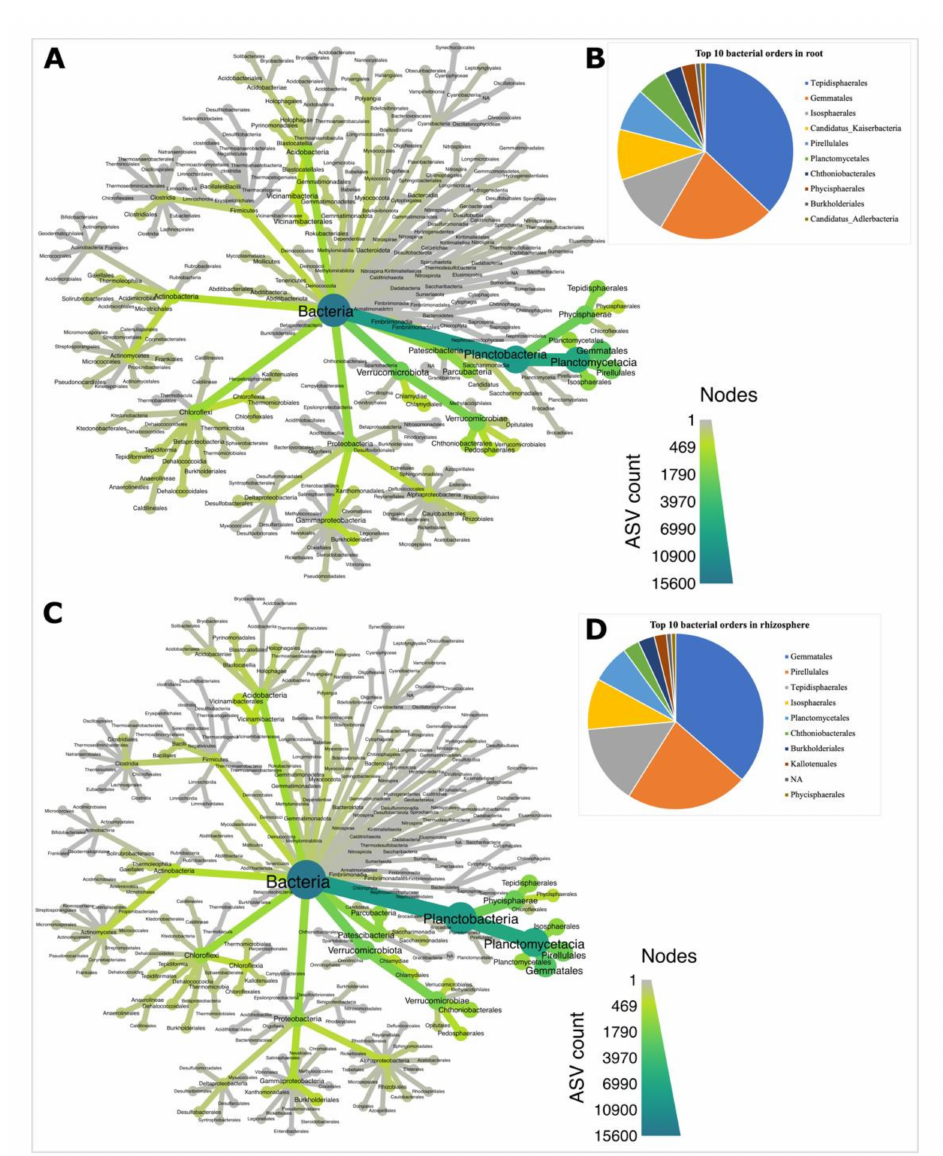
Figure 2. Taxonomic hierarchy and associated observations of ASVs (taxmap) for bacterial communities. Taxmap at order level in root ( A ) and relative abundance of top 10 orders in root ( B ). Taxmap at order level in rhizosphere ( C ) and relative abundance of top 10 orders in rhizosphere biotope ( D